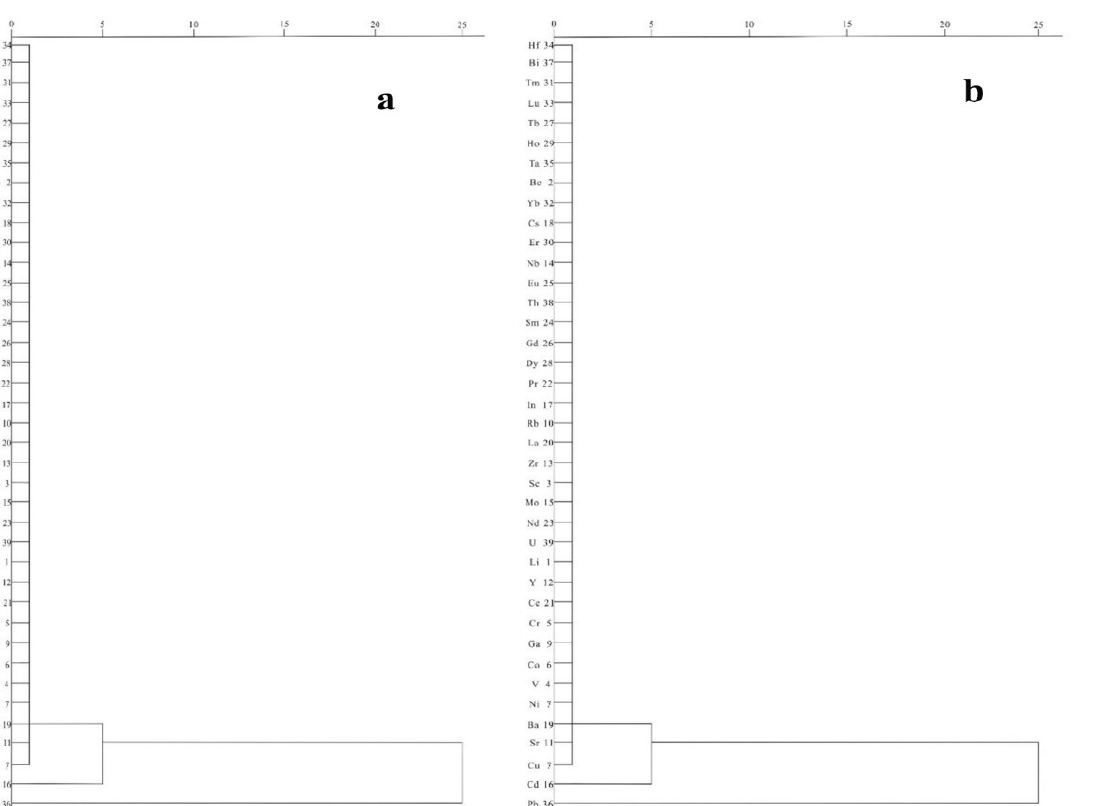
Figure 4. Pedigree diagram of element clustering in samples A ( a ) and A 1 ( b ).